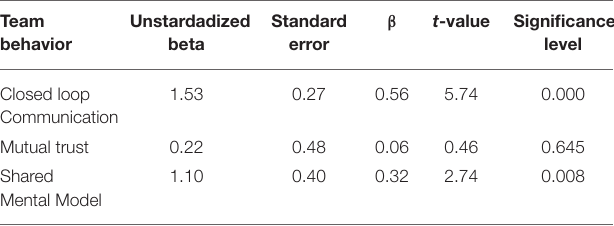
TABLE 6 | Unstandardized and standardized coefficient ( β ), standard error, t -values, and significance levels for decision-making behavior regressed upon coordinating mechanisms.